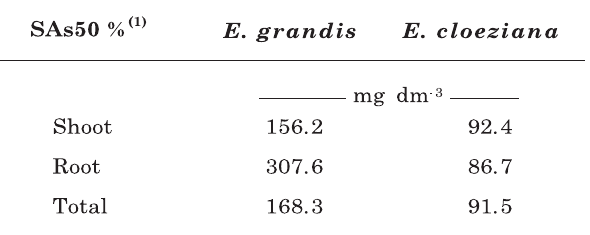
Table 4. The concentration of available As (Mehlich- 3) in soil (SAs50 %) causing reductions of 50 % in the root, shoot and total biomass of E. grandis and E. cloeziana seedlings grown in soil samples treated with As